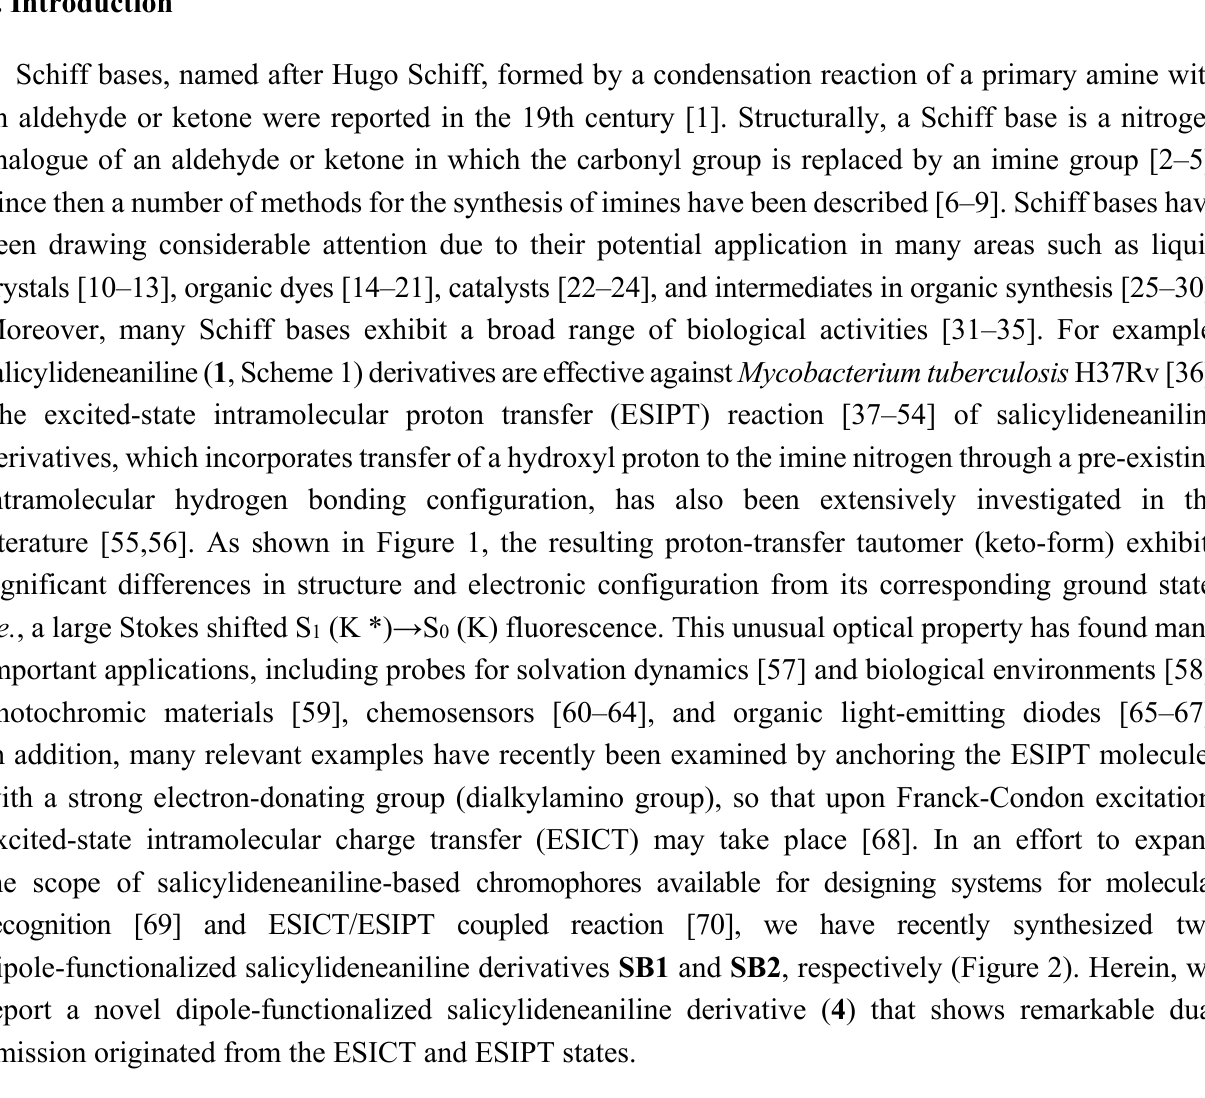
Figure 1. Characteristic four-level photocycle scheme of the ESIPT